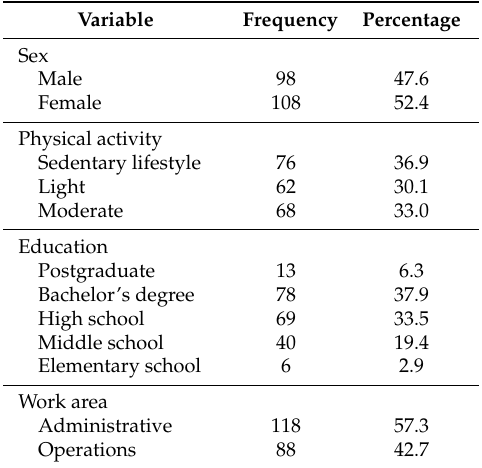
Table 2. General characteristics of the population ( n = 206).